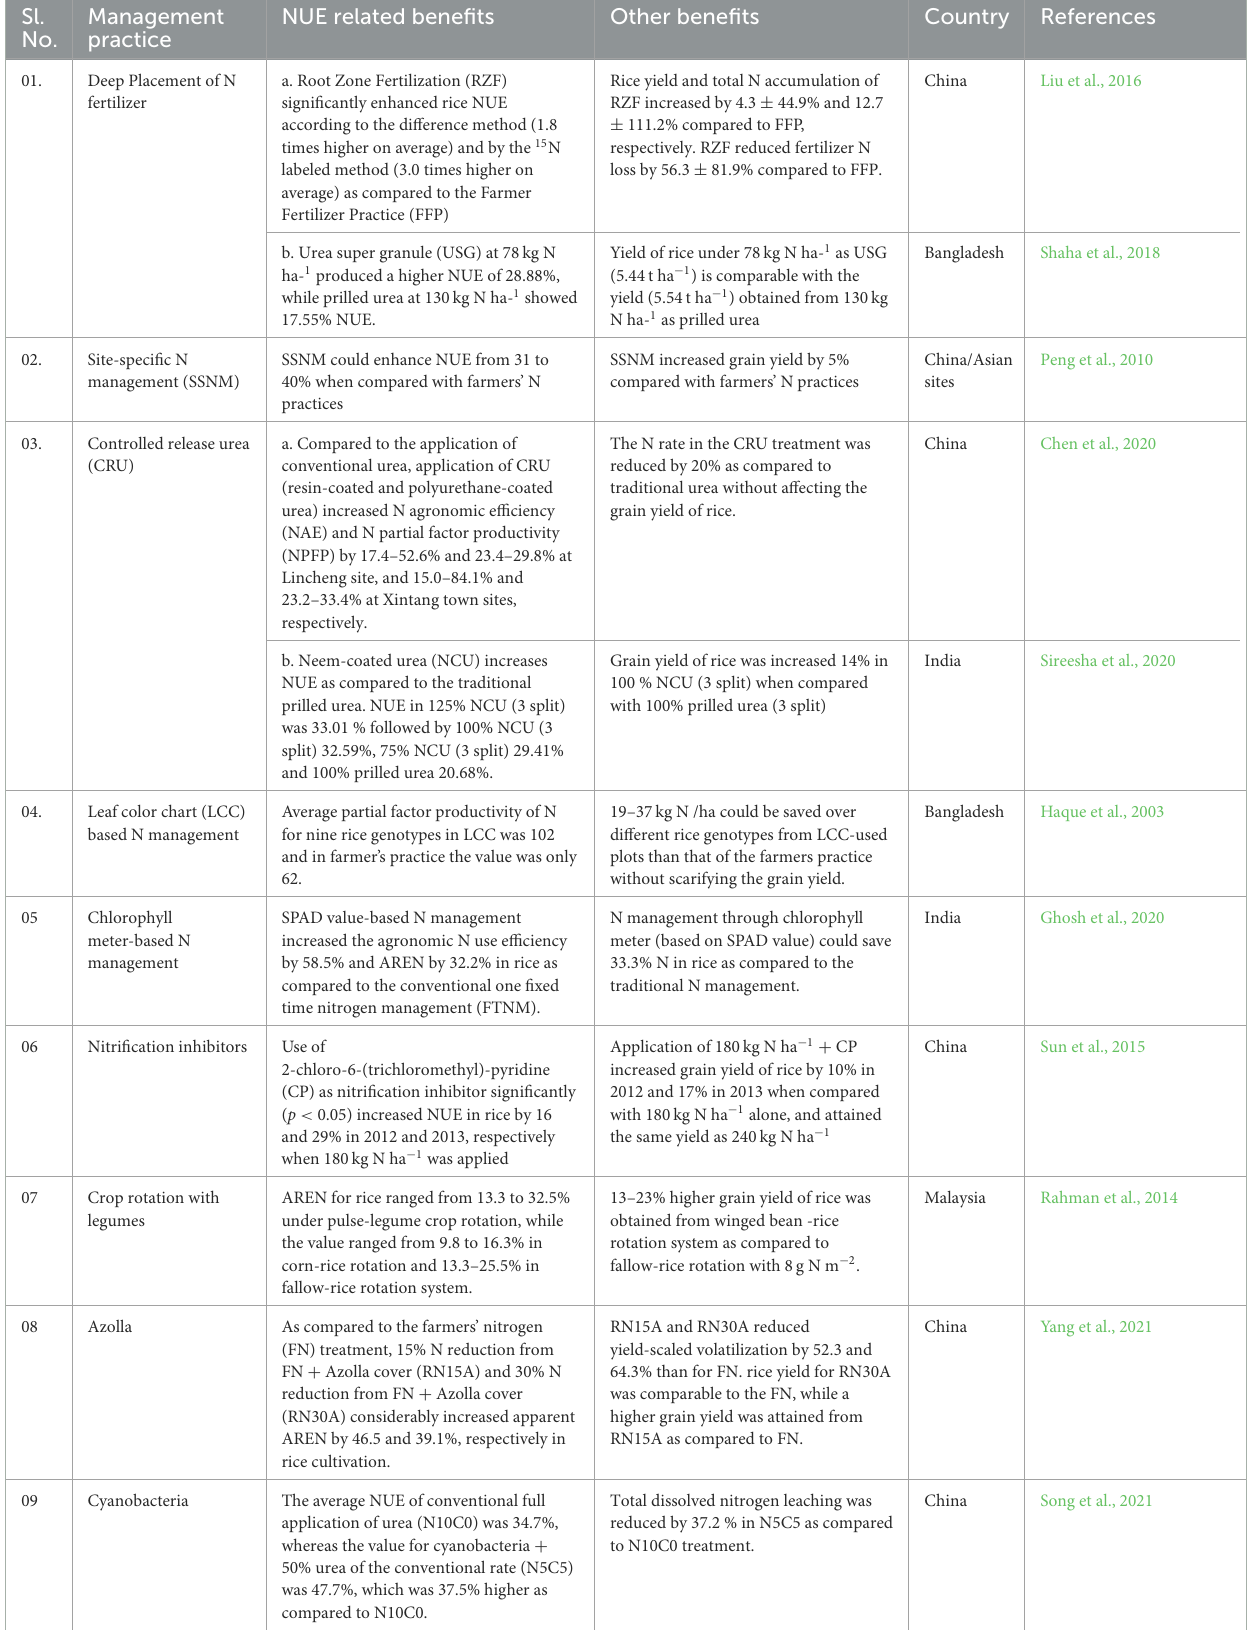
TABLE 3 Nitrogen use efficiency (NUE) under different management practices. Sl.